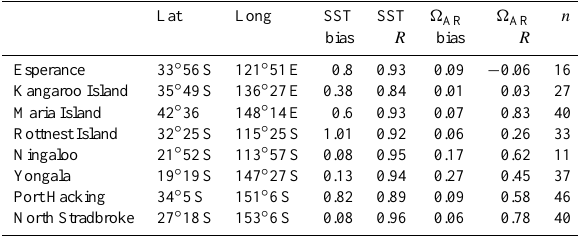
Table 2. The biases and correlation coefficients calculated ( R ) at the NRS sites for SST (HadiSST) and reconstructed aragonite satu- ration state ( (cid:127) AR ) within the Australia number of observations used in calculating the biases and